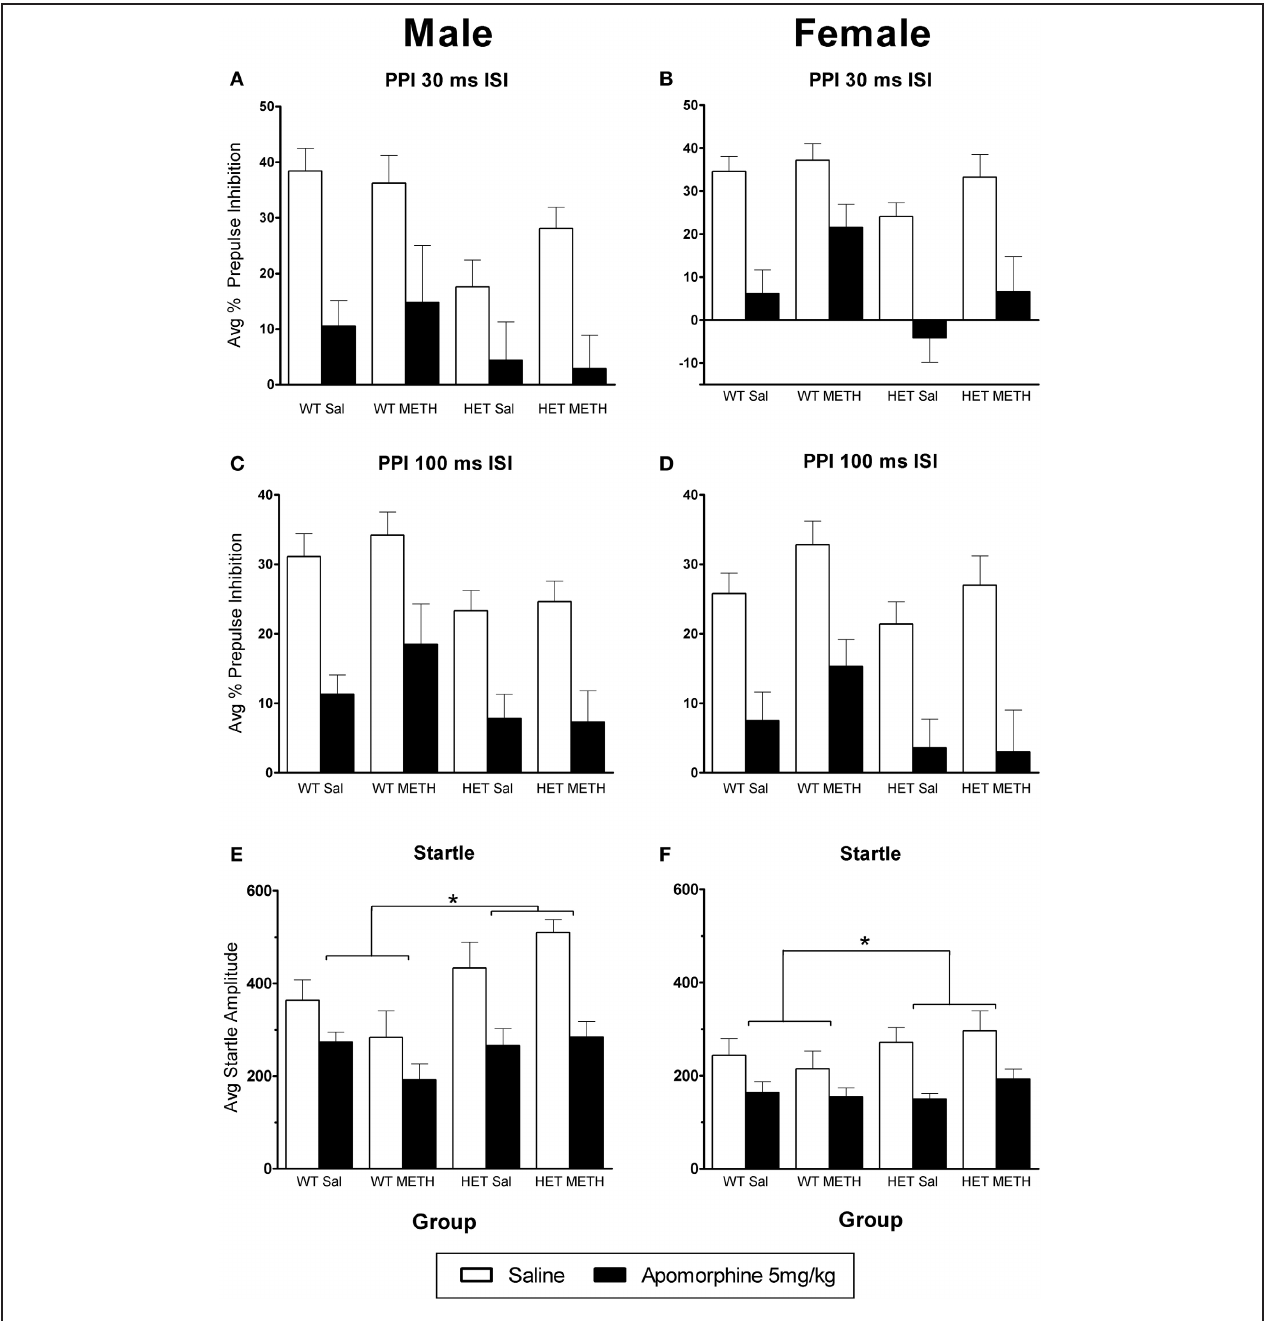
FIGURE 4 | APO-induced disruption of PPI. (A–D) PPI following an APO challenge in male (A) and female (B) mice at the 30ms ISI and male (C) and female (D) mice at the 100ms ISI. APO disrupted PPI in all groups, and this